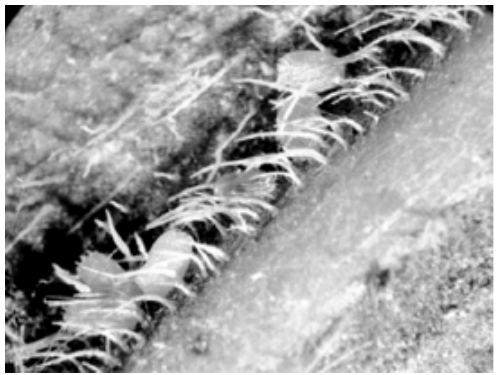
Fig. 1 . Photograph of the eggs